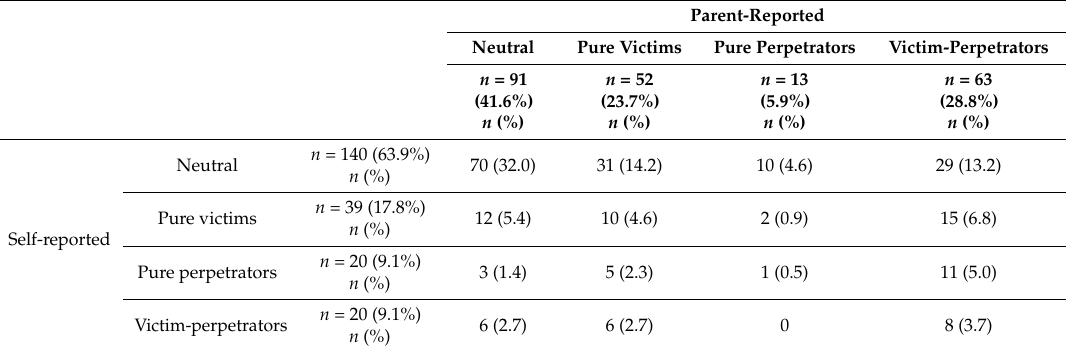
Table 2. Self-reported and parent-reported bullying involvement ( n =